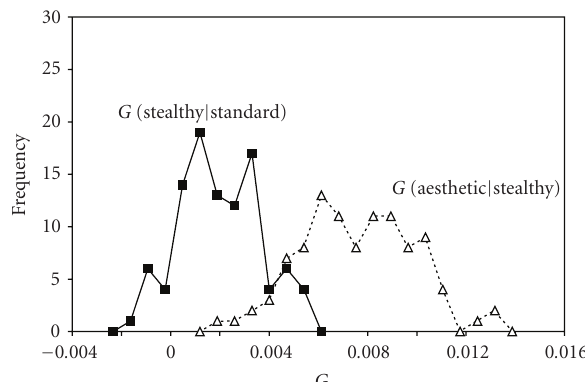
Figure 6: G ( P 1stealthy | P 0standard ) and G ( P 1aesthetic | P 0stealthy ) for γ = 15% .